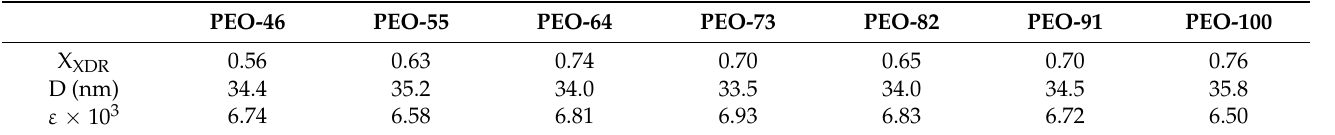
Table 2. Estimated crystalline fraction, crystallite size and micro-strain generated for all materials